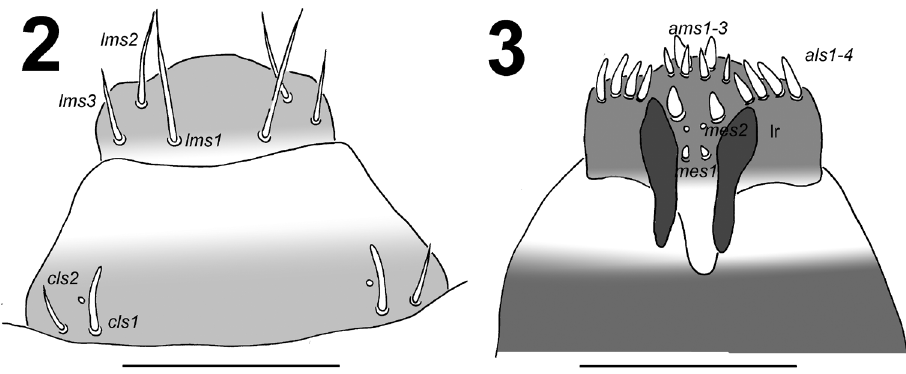
Figures 2–3. Larinus vulpes mature larva, mouth parts. 2 Labrum and clypeus 3 Epipharynx. Abbrevia- tions: ams – anteromedial s., als – anteriolateral s., cls – clypeal s., mes – median s., lms – labral s., lr – labral rods. Scale bar 0.2